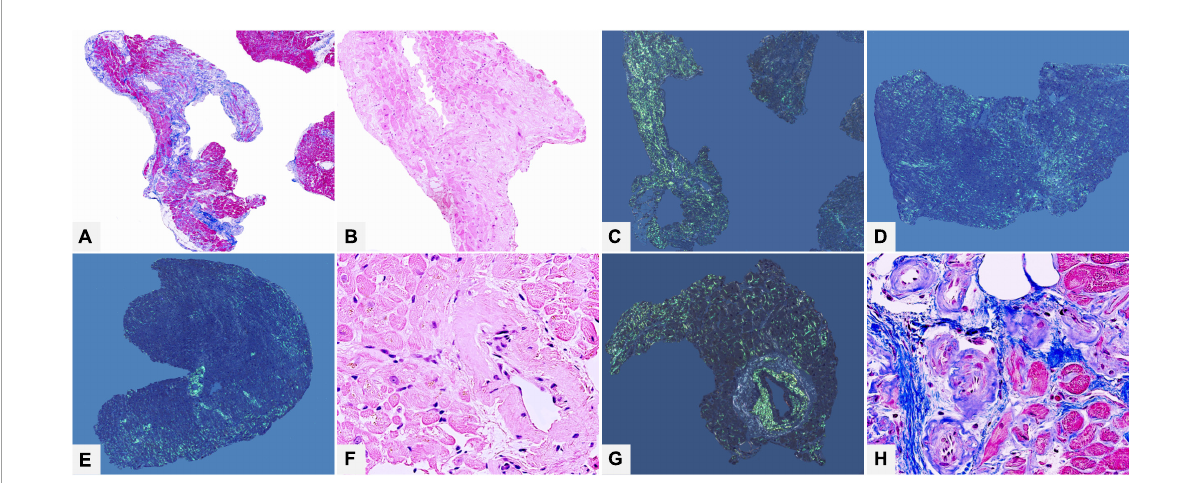
FIGURE9 Male of 62 years affected by clinically not well defined cardiopathy with hypertrophic phenotype. Thorax computed tomography showed mediastinal lympho-adenomegaly and a pulmonary picture suggestive of grade 2 sarcoidosis. Endomyocardial biopsy identified cardiac amyloidosis with diffuse myocardial interstitial (A–D) and vascular (E–H) deposits. Immunohistochemistry typing (not shown) suggested AL, most probably related to lambda light chain, later confirmed by proteomics. Subsequent hematological tests confirmed the disease and a bone marrow biopsy defined the underlying plasma cell dyscrasia: low grade multiple myeloma. The final diagnosis was systemic lambda light chain amyloidosis with lymph node and cardiac involvement in clinical onset stage I. (A) Azan Mallory trichrome 50 × . (B) Hematoxylin-Eosin 100 × . (C,D) Congo red under polarized light, 50 × . (E) Congo red under polarized light, 50 × . (F) Hematoxylin-Eosin 400 × . (G) Congo red under polarized light, 100 × . (H) Azan Mallory trichrome 400 ×